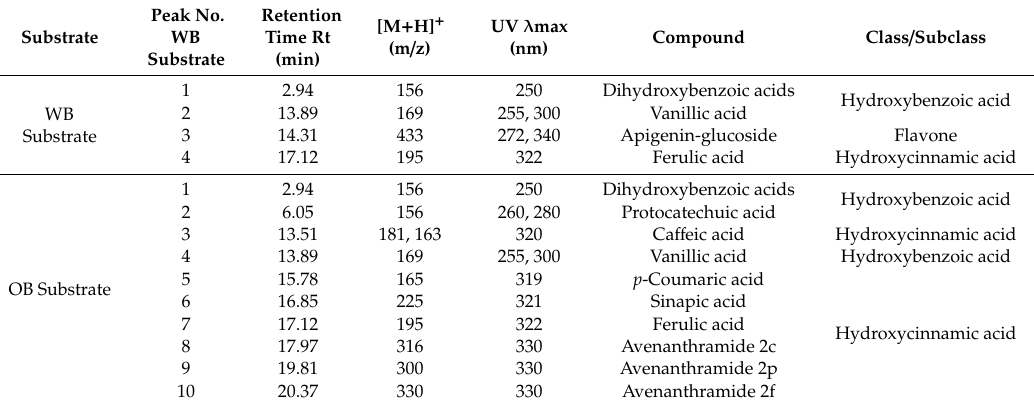
Table 1. Identification of phenolic compounds in fermented samples on WB and OB substrates.